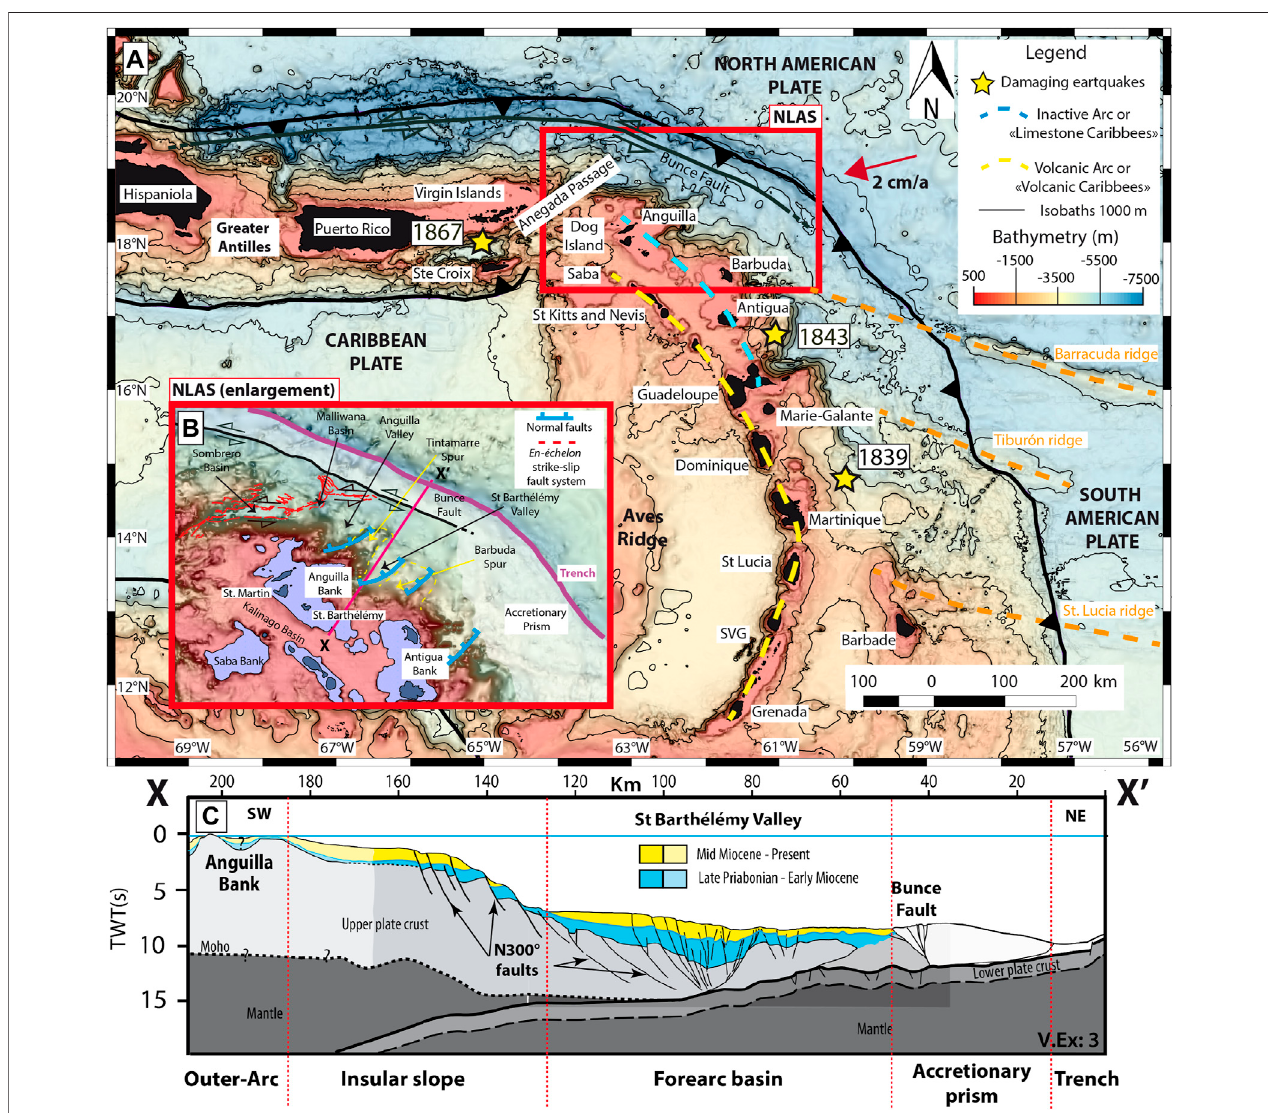
FIGURE 1 | (A) General map of the Lesser Antilles subduction zone. The red box indicates the study area (the NLAS) and refers to Figure 1B and Figure 2 . The orange dashed lines represent the ridges. (B) Enlargement of the Northern Lesser Antilles Segment. (C) XX ′ cross-section (modi fi ed from Boucard et al., 2021).